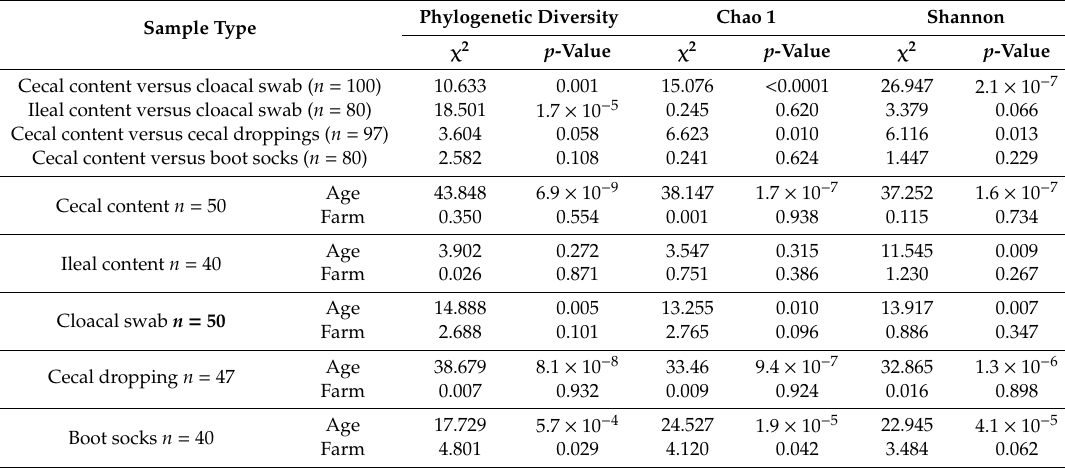
Figure 1. Phylogenic diversity (ASV level) of different sample types for both sampled farms across 0, 2, 7, 14 and 35 days of age. Whiskers show 95% interval, box 50% interval, n = 10, circles are boot socks, triangles are cecal content, squares are cecal droppings, pluses are cloacal swabs and squares with cross are ileal content samples. Table 1. Different α diversity measures (ASV level) across different samples types. Number of broilers tested is specified in the table row (Kruskal–Wallis).